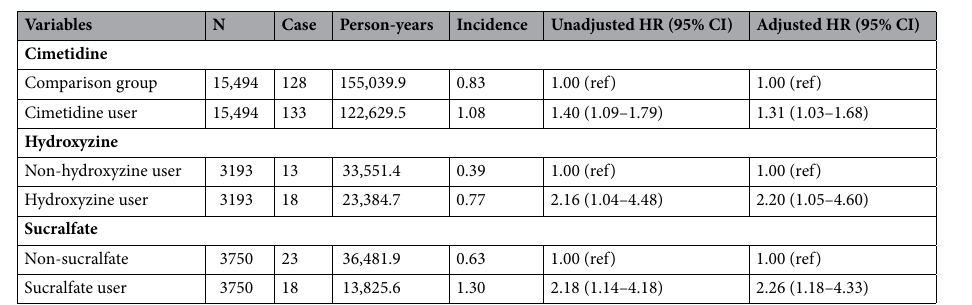
Figure 2. Selection of the study participants.